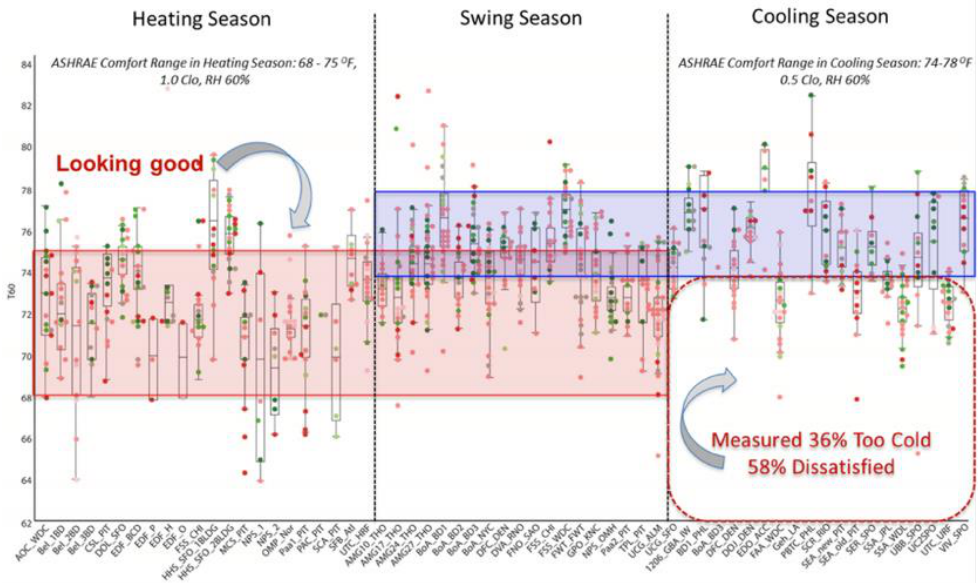
Figure 3. Air temperature at 60 cm from the floor ( n = 1282).